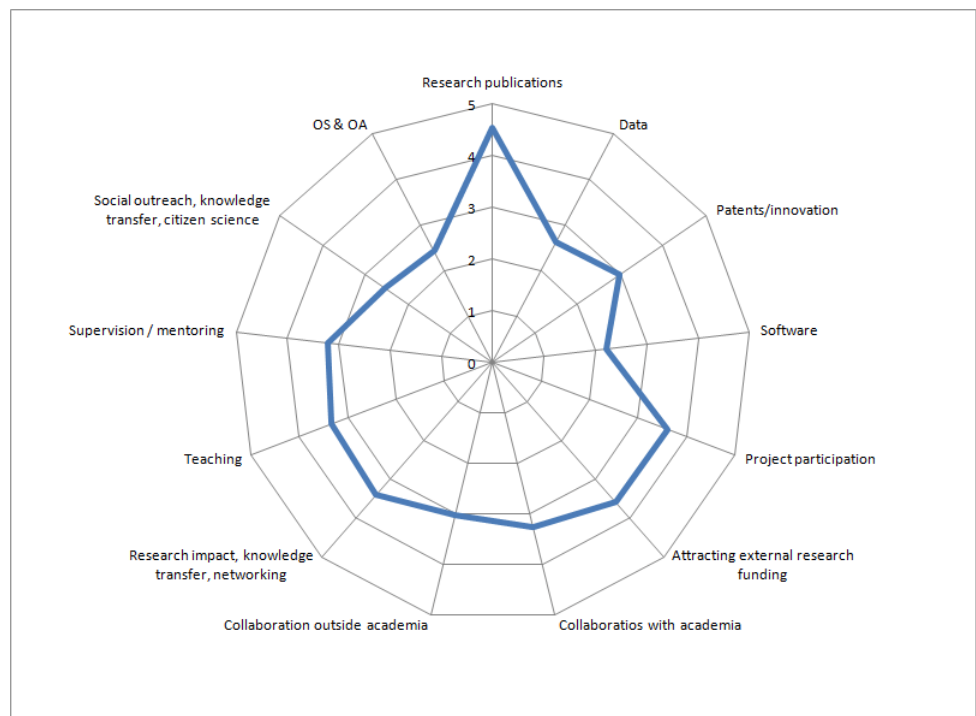
Figure 2. The importance of various parameters in research evaluation (survey data).